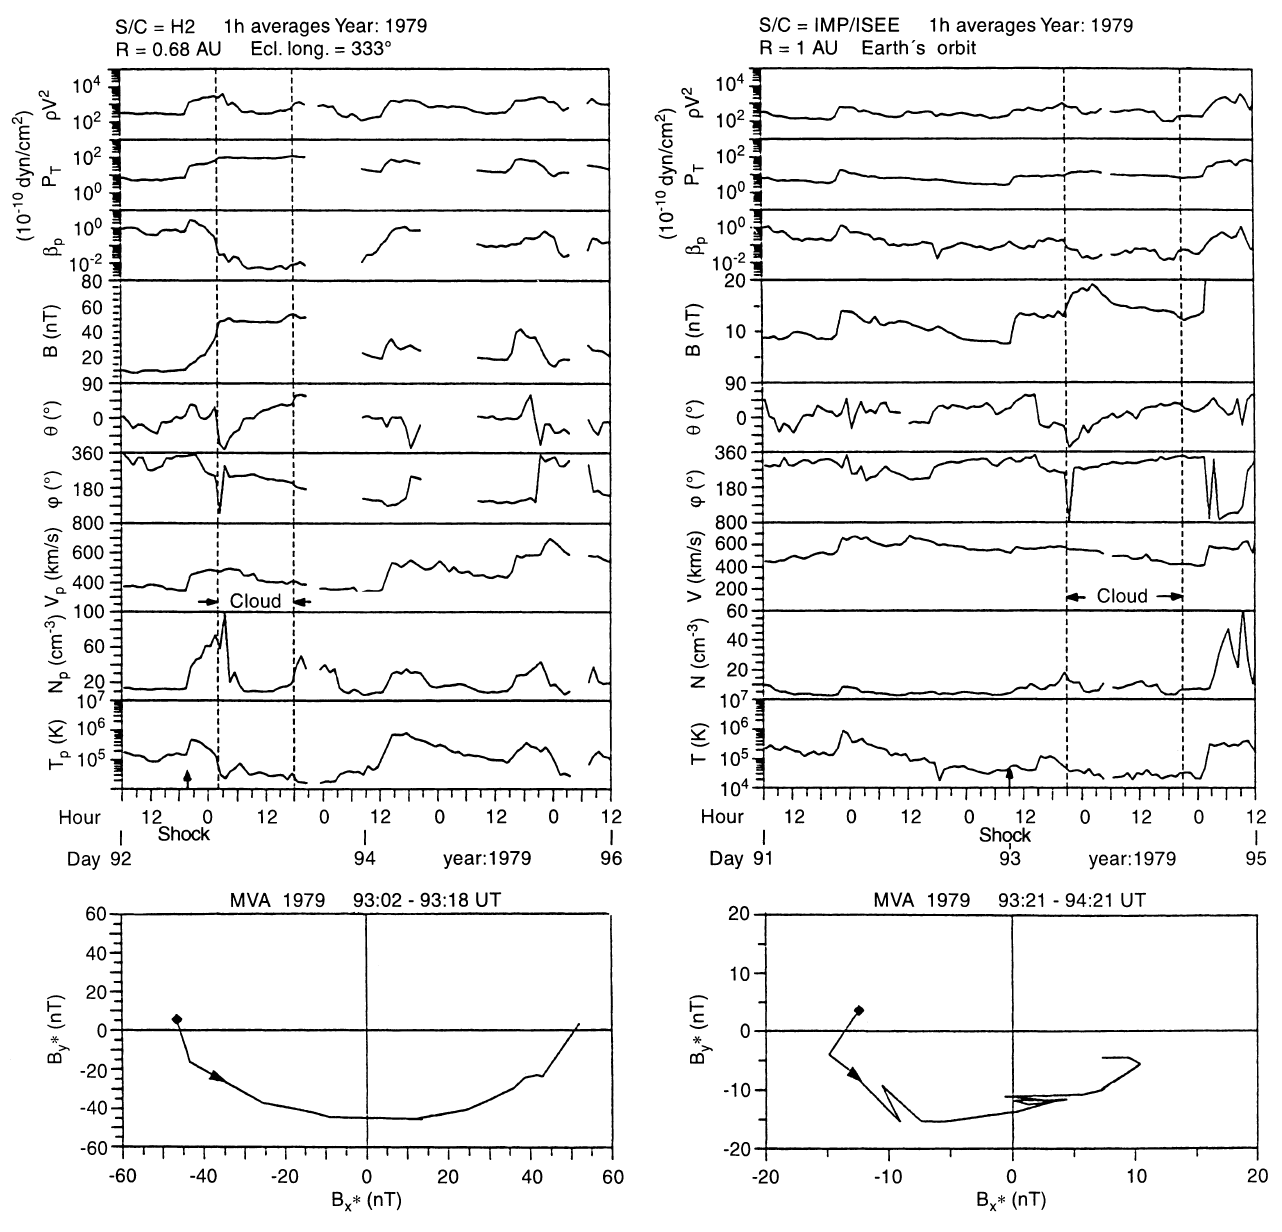
of the associated shocks: day 92, 20 UT at Helios 2; day 93, 09 UT at IMP/ISEE. Results from the MVA of the magnetic field data are displayed in the bottom